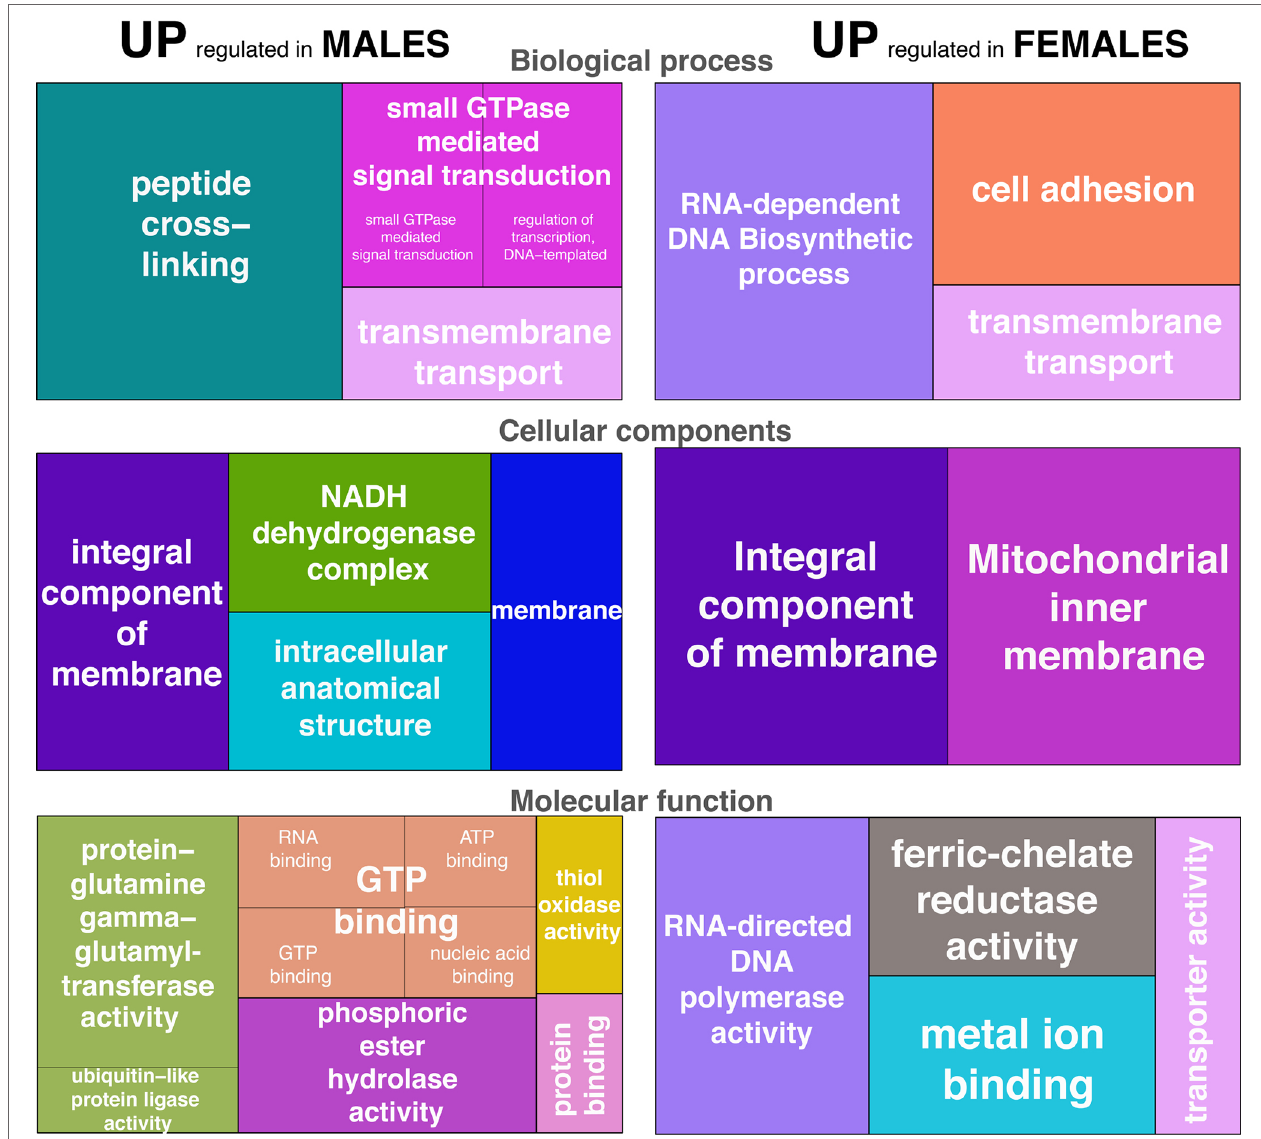
FIGURE 2 | Gene ontology (GO) treemaps for DE genes annotated in A. lixula . Those up-regulated in males and females are represented separately for Biological processes, Cellular components, and Molecular functions. The size of the rectangles reflects the adjusted p - values associated with the differentially regulated